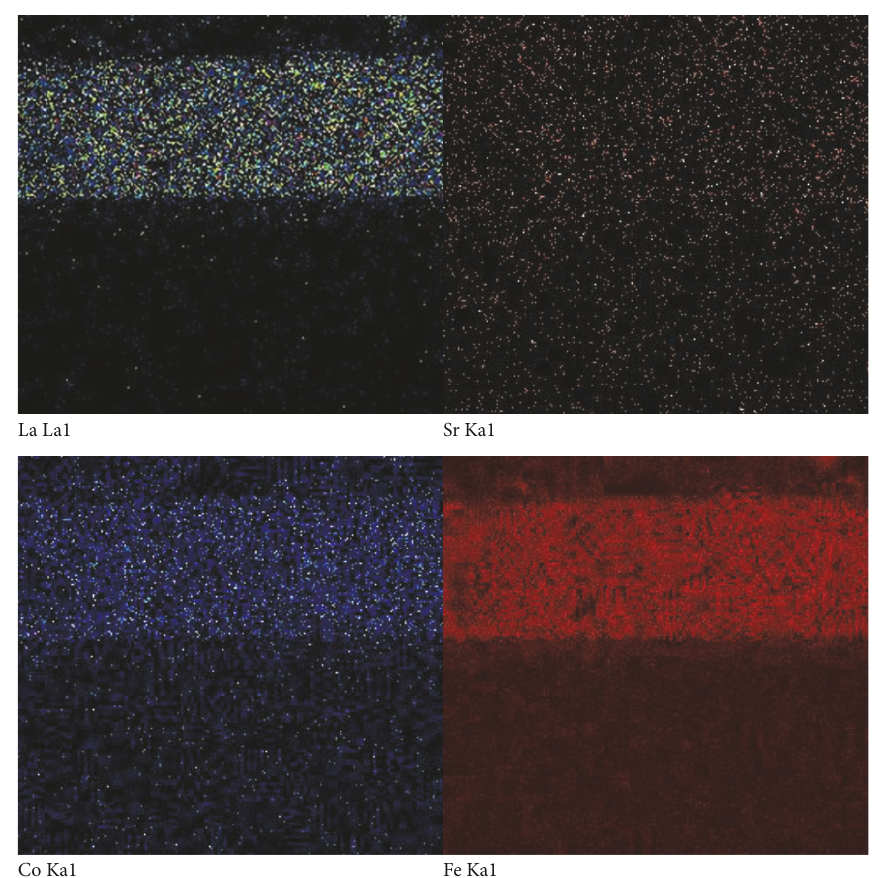
Figure 3: EDS chemical maps for La, Sr, Co, and Fe